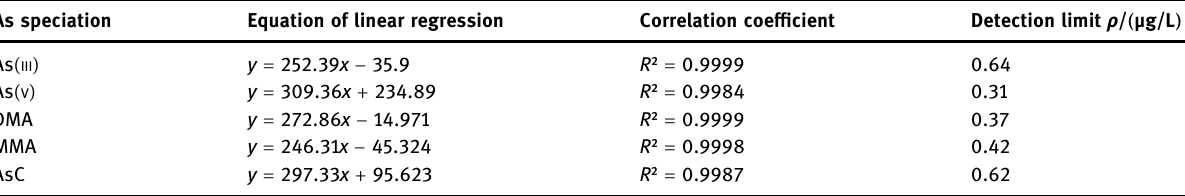
Table 4: Linear parameters and detection limits of fi ve As speciation